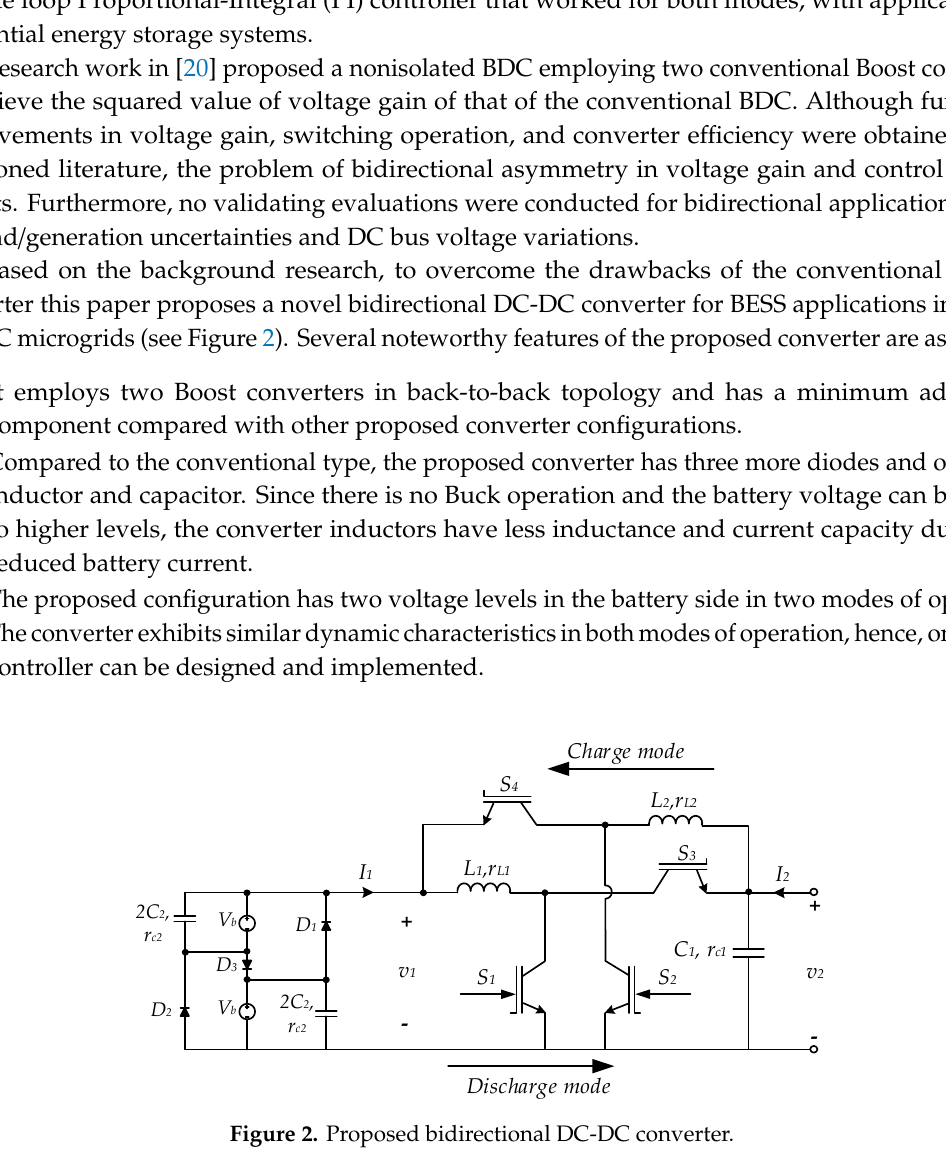
Figure 3. Hybrid microgrid under the study.